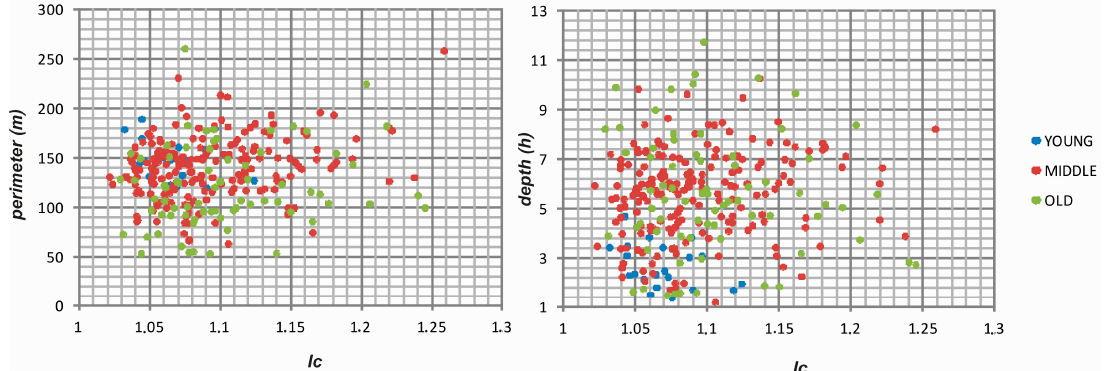
Figure 11. The correlations between circularity index (Ic) and perimeter and depth for conglomerates by age.